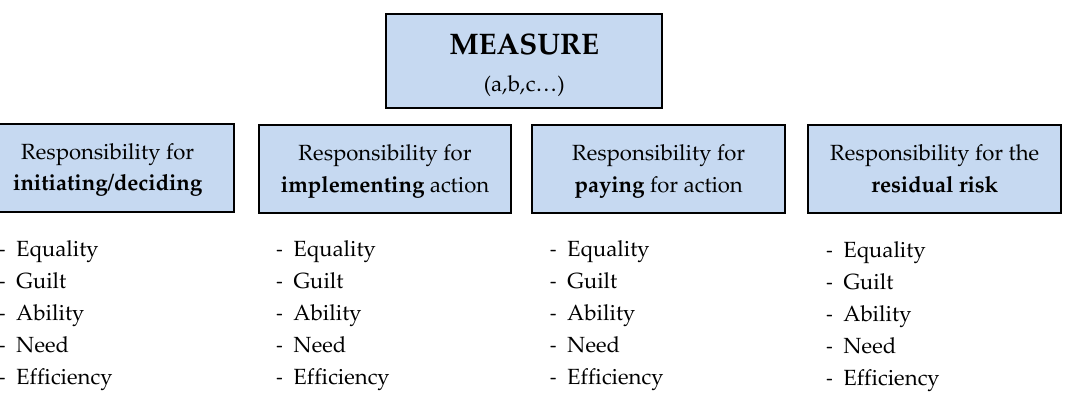
Figure 1. Framework for analyzing responsibility for adaptation measures (step 1, identify adaptation measures; step 2, for measures a,b,c… analyze possible responsibility distributions for different tasks based on the normative principles).